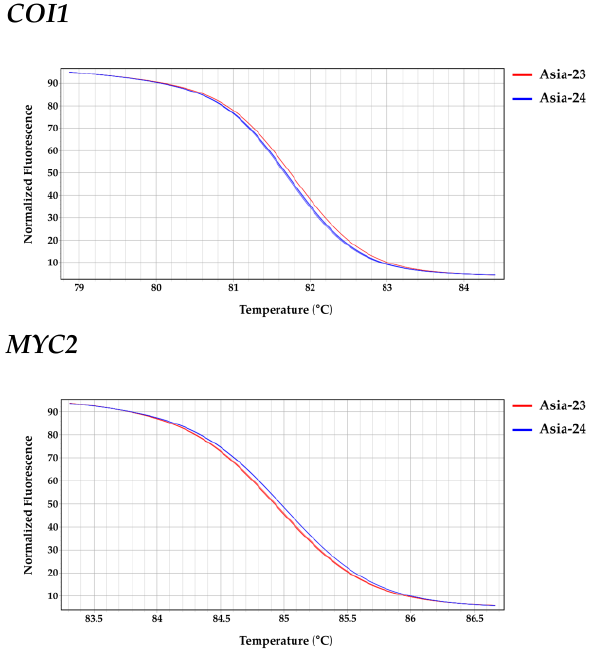
Figure 7. HRM analysis of each selected gene in Asia-23 and Asia-24. Red line: Average normalized fluorescence curve of Asia-23, Blue line: Average normalized fluorescence curve of Asia-24. Table 1. HRM analysis results of each gene statistically grouped using the MP-HRM analysis method. Gene